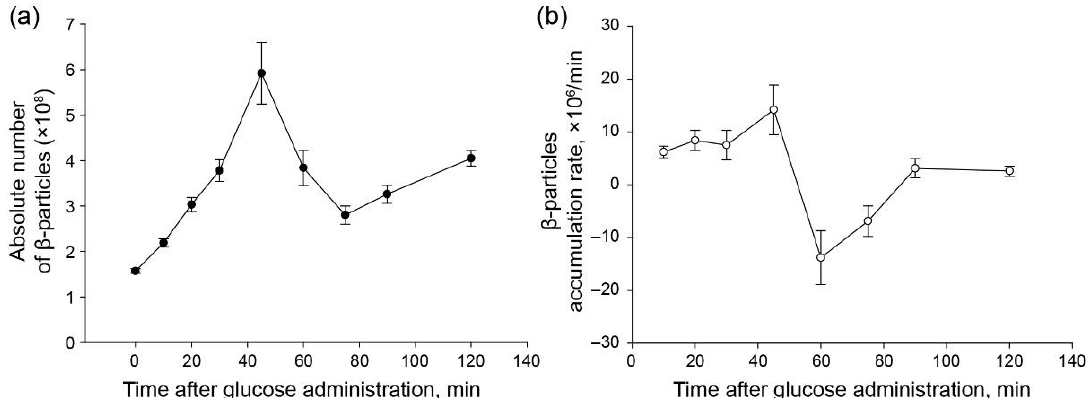
Figure 3. Dynamics of the absolute number of β -particles in hepatocytes ( a ) and their accumulation rate ( b ) at different time intervals after glucose administration to fasting rats.